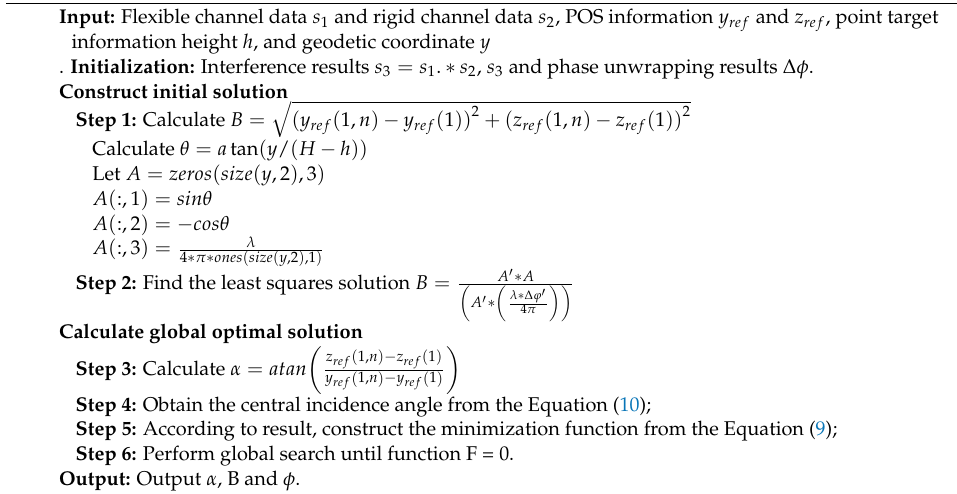
Algorithm 2 Global optimization combined with least squares for the flexible baseline.